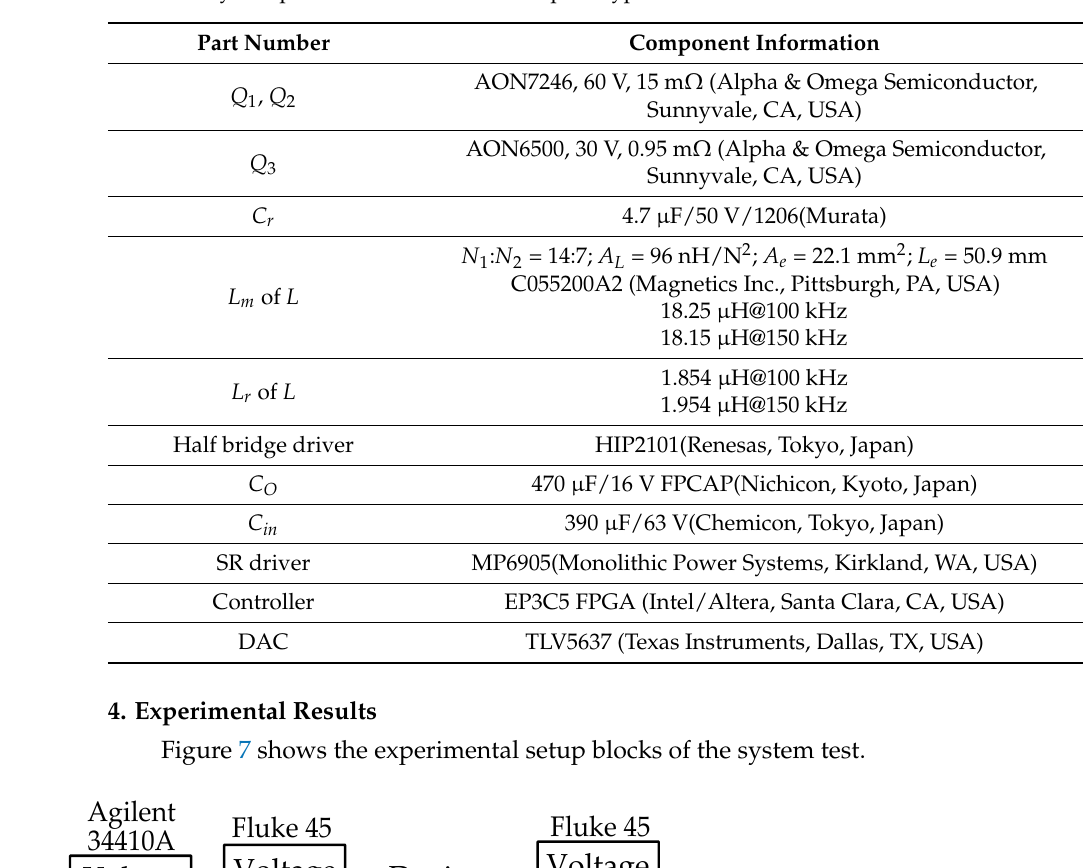
13 of 24 Table 2 is the list of the key components in the prototype circuit. Table 2. Key components information of the prototype circuit.